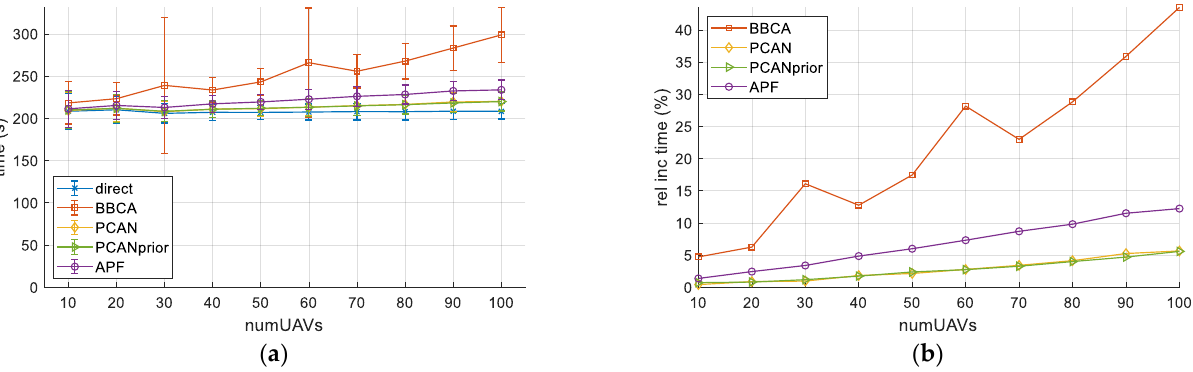
Figure 10. Flight time: ( a ) absolute values (mean and standard deviation); ( b ) relative increase with respect to the direct algorithm.